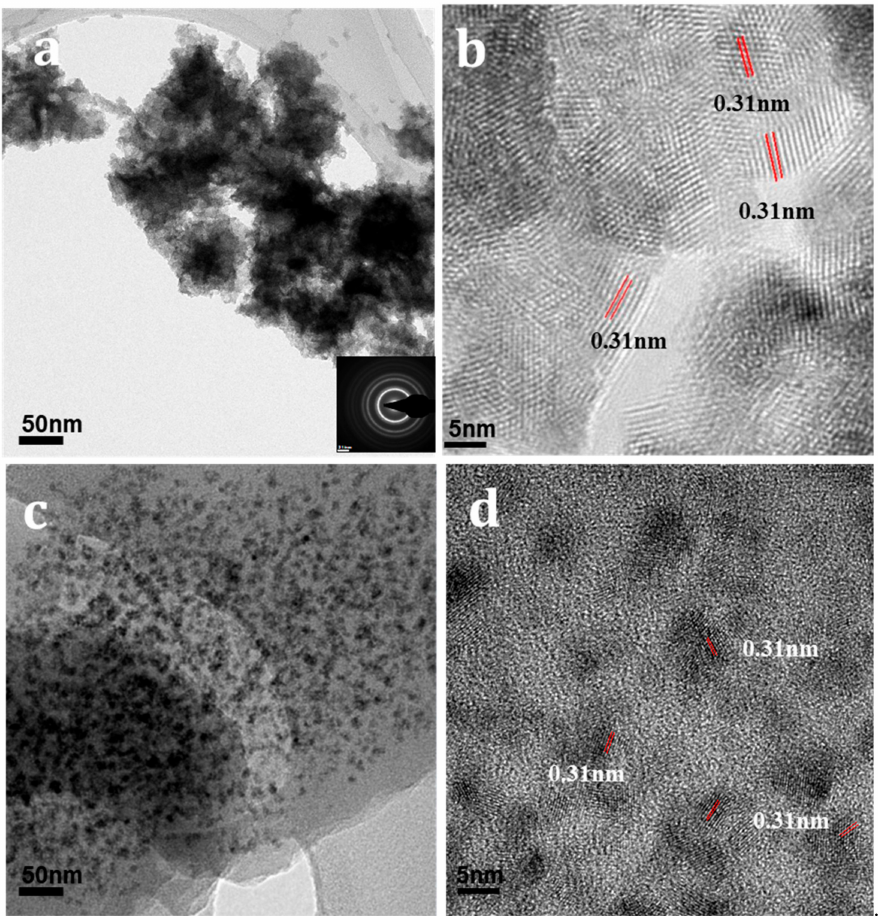
Figure 2. ( a ) Transmission electron microscope (TEM) image and ( b ) high-resolution TEM (HRTEM) of CeO 2 nanoparticles. ( c ) TEM image and ( d ) HRTEM image of polymer composite with 40 wt% CeO 2